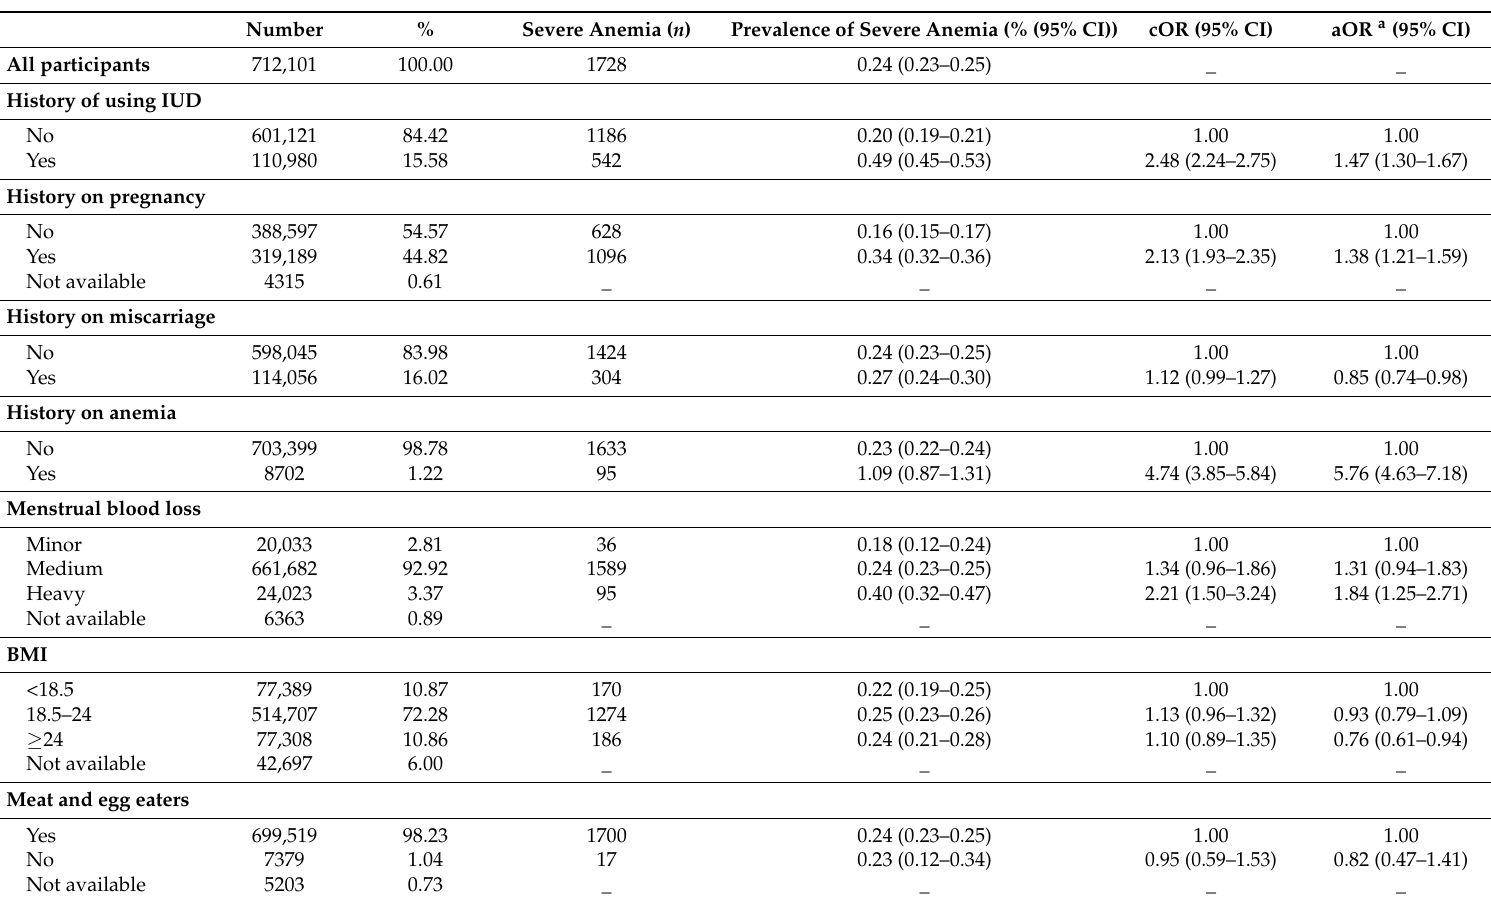
Table 2. Histories on using contraceptive methods, reproduction, health status, and severe anemia prevalence among non-pregnant women of reproductive age in 2012, rural